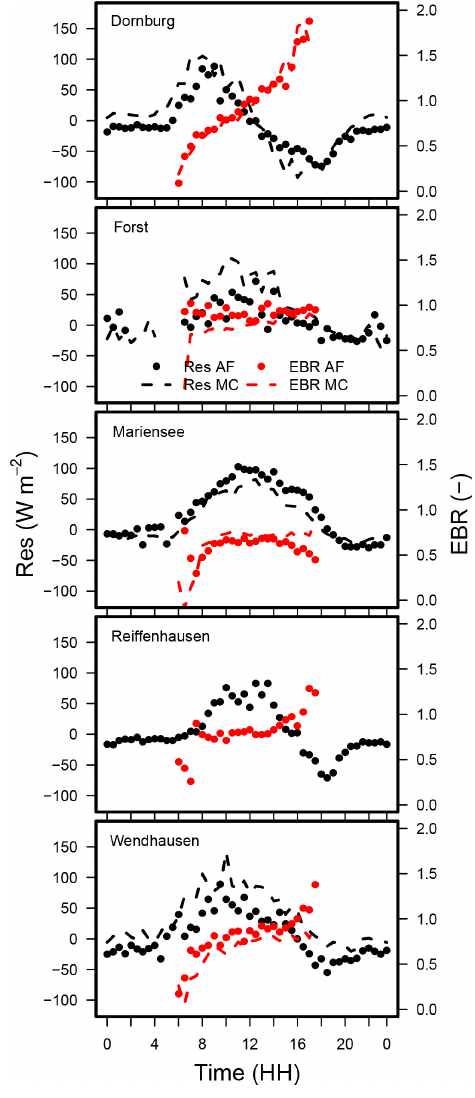
Figure 6. Median diel cycle of the energy balance ratio (EBR) and diurnal cycle of the residual energy for the AF and the MC systems at all sites. LE and H were obtained by EC. Data from Reiffen- hausen MC are missing due to the unavailability of a campaign.